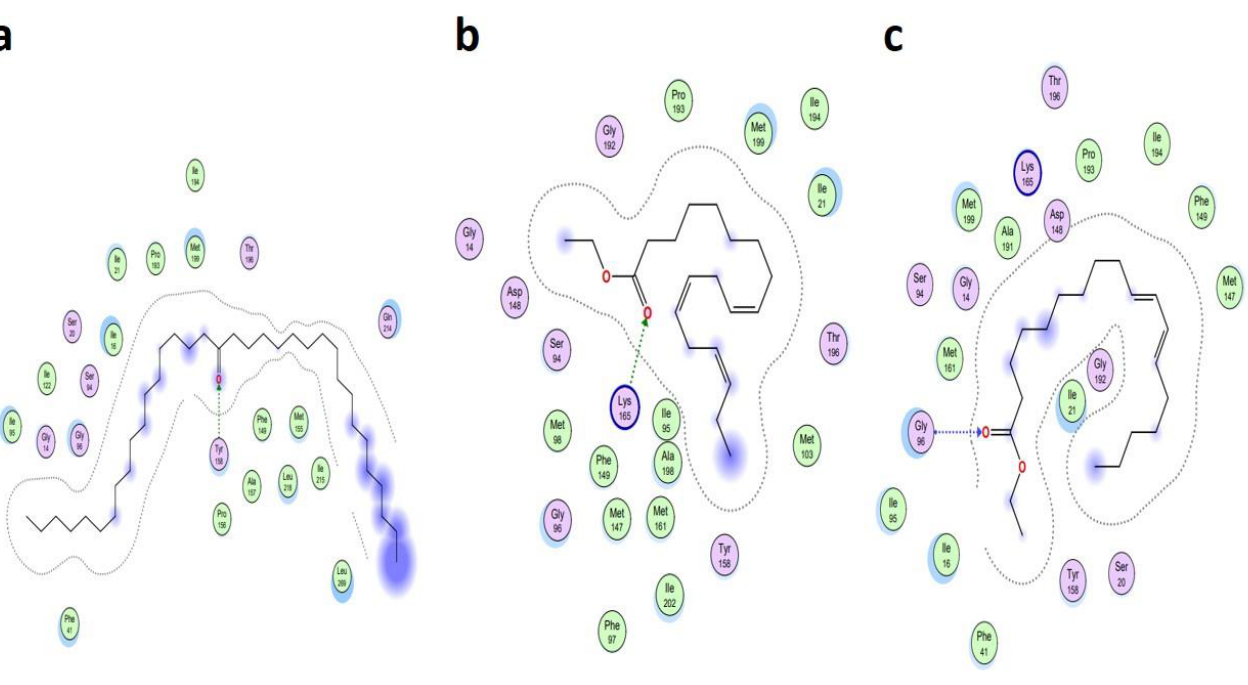
Figure 9. Interaction plot of top three scored docked ligands CID_10440 ( a ), CID_5367460 ( b ), and CID_22371644 ( c ), within active site of antibacterial protein [PDB ID: 4TZK], in the vicinity of